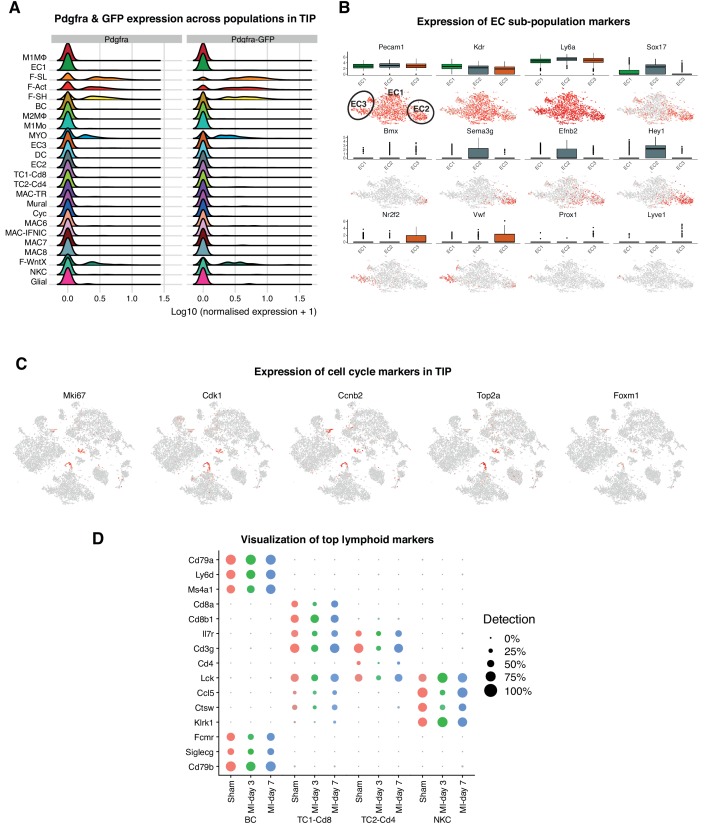
Gene expression data for TIP sub-populations.(A) Distribution of Pdgfra and Pdgfra-GFP expression across cell populations in TIP. (B) Expression of selected endothelial markers as visualized in box and t-SNE plots. (C) Expression of selected cell cycle marker genes on t-SNE plots. (D) Dot plot visualization according to condition of top marker genes for lymphoid lineage populations.